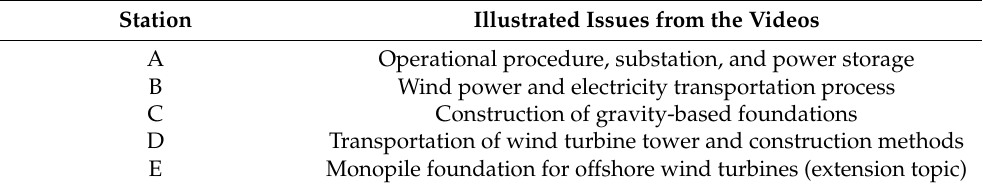
Figure 11. An example of the attributes in the main station. ( A ) Attributes of the object; ( B ) Zoom-in the attributes in ( A ), where Symbol 1: manufacturer, symbol 2: type of power generation, Symbol 3: specification, Symbol 4: capacity, Symbol 5: diameter of fan, Symbol 6: weight. Table 5. Illustrated issues from the videos.